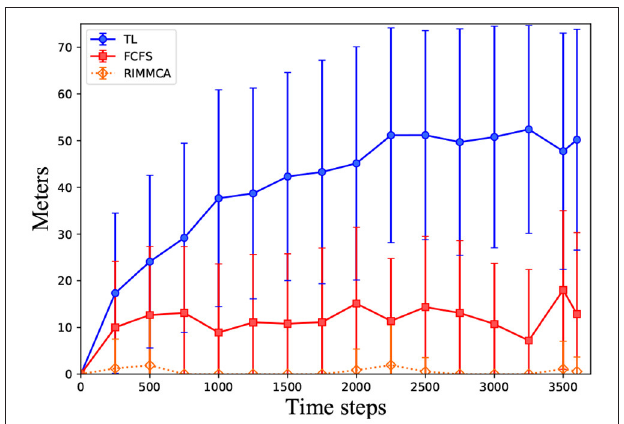
FIGURE 7 | Average queuing length results with standard deviation of four different in-lane obstruction scenarios (20 runs per scenario).